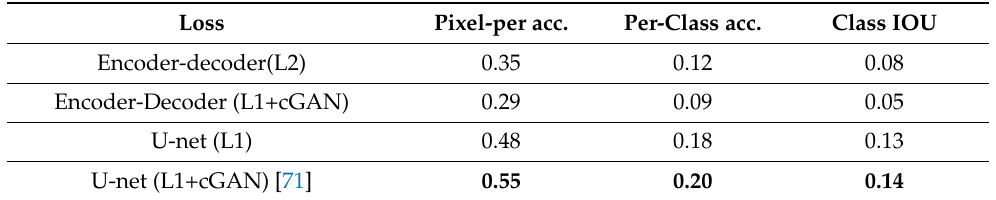
Table 11. FCN-scores for different generator architectures